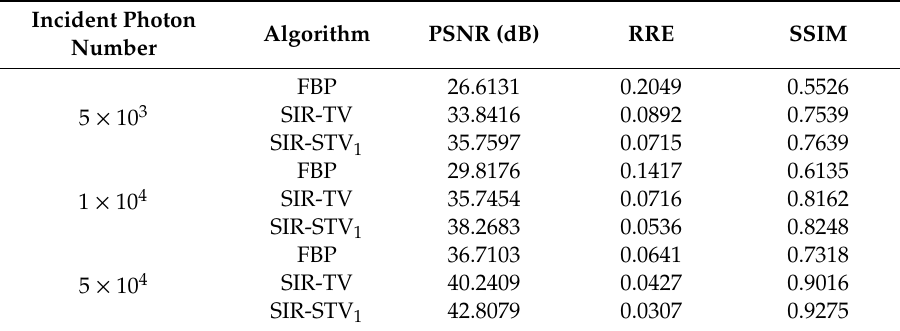
Table 1. Image quality